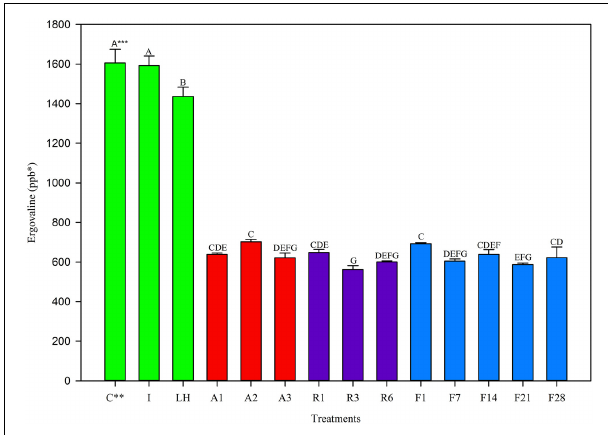
FIGURE 2 | Ergovaline concentration of all tall fescue sub-samples in various storage conditions from August 2012 harvest. ∗ Parts per billion. ∗∗ Treatment abbreviations are as follows: C, Control; I, Ice; LH, Light + Heat; A1, Ambient Day 1; A2, Ambient Day 2; A3, Ambient Day 3; R1, Refrigerator Day 1; R3, Refrigerator Day 3; R6, Refrigerator Day 6; F1, Freezer Day 1; F7, Freezer Day 7; F14, Freezer Day 14; F21, Freezer Day 21; and F28, Freezer Day 28. ∗∗∗ Matching letters indicate no statistical difference at a significance level of P < 0 . 05.